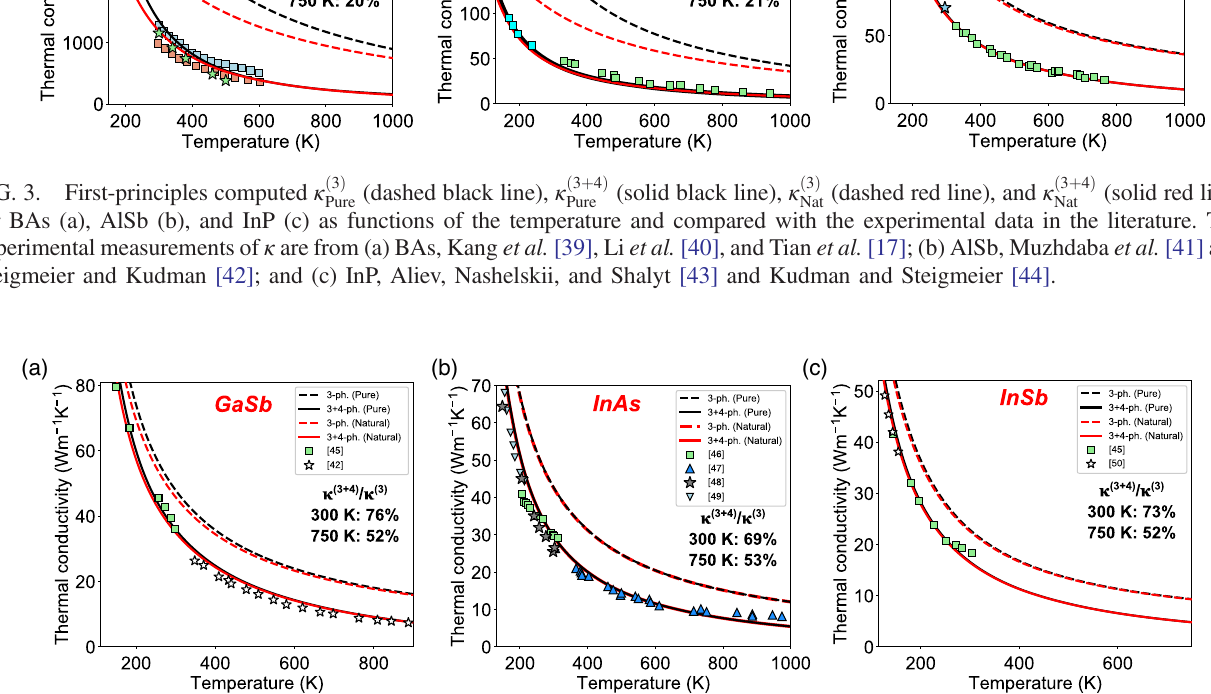
FIG. 4. First-principles computed κ for GaSb (a), InAs (b), and InSb (c) as functions of the temperature and compared with the experimental data in the literature. The experimental measurements of κ are from (a) GaSb, Holland [45] and Steigmeier and Kudman [42]; (b) InAs, Arasly, Ragimov, and Aliev [46], Bowers, Bauerle, and Cornish [47], Le Guillou and Albany [48], and Tamarin and Shalyt [49]; and (c) InSb, Holland [45] and Shalyt, Tamarin, and Ivleva